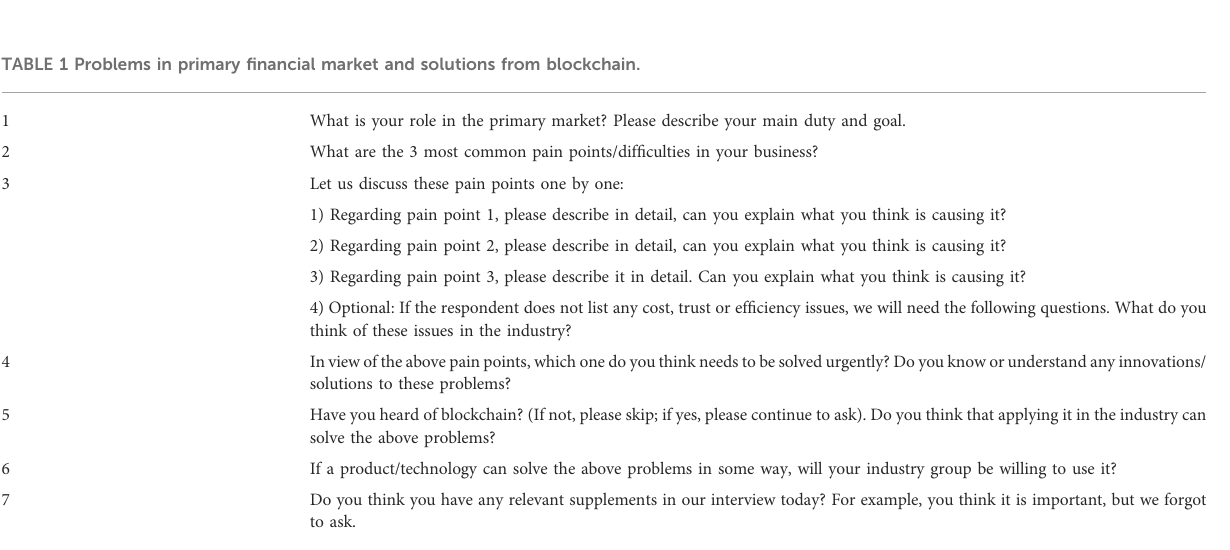
FIGURE 2 Methodology design.